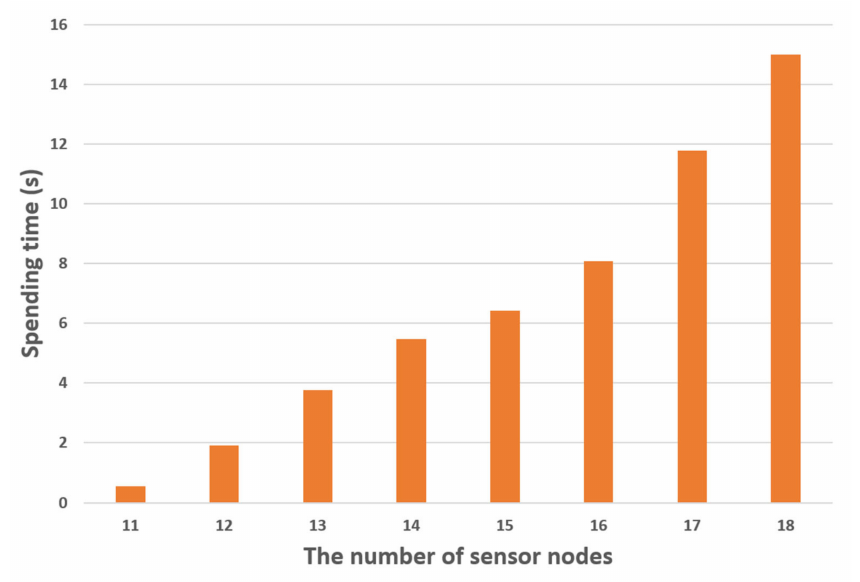
Figure 6. Average time spent by the proposed